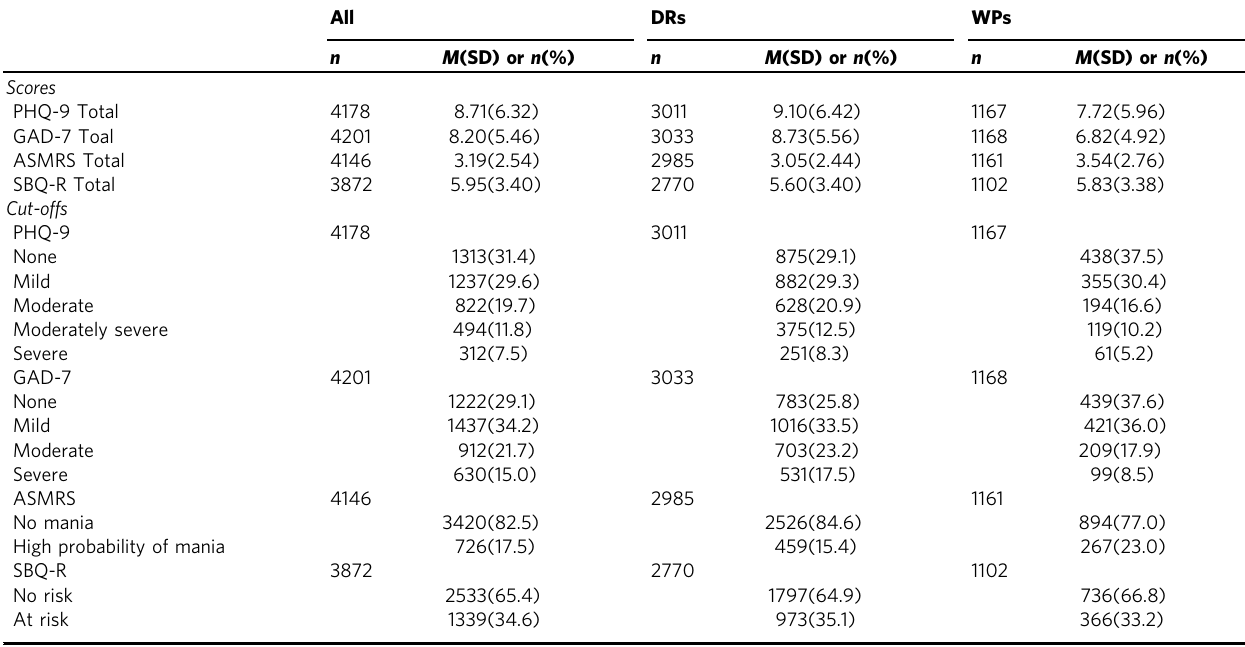
Table 3 Descriptive statistics for all clinical outcome measures for all participants and separated by DRs and